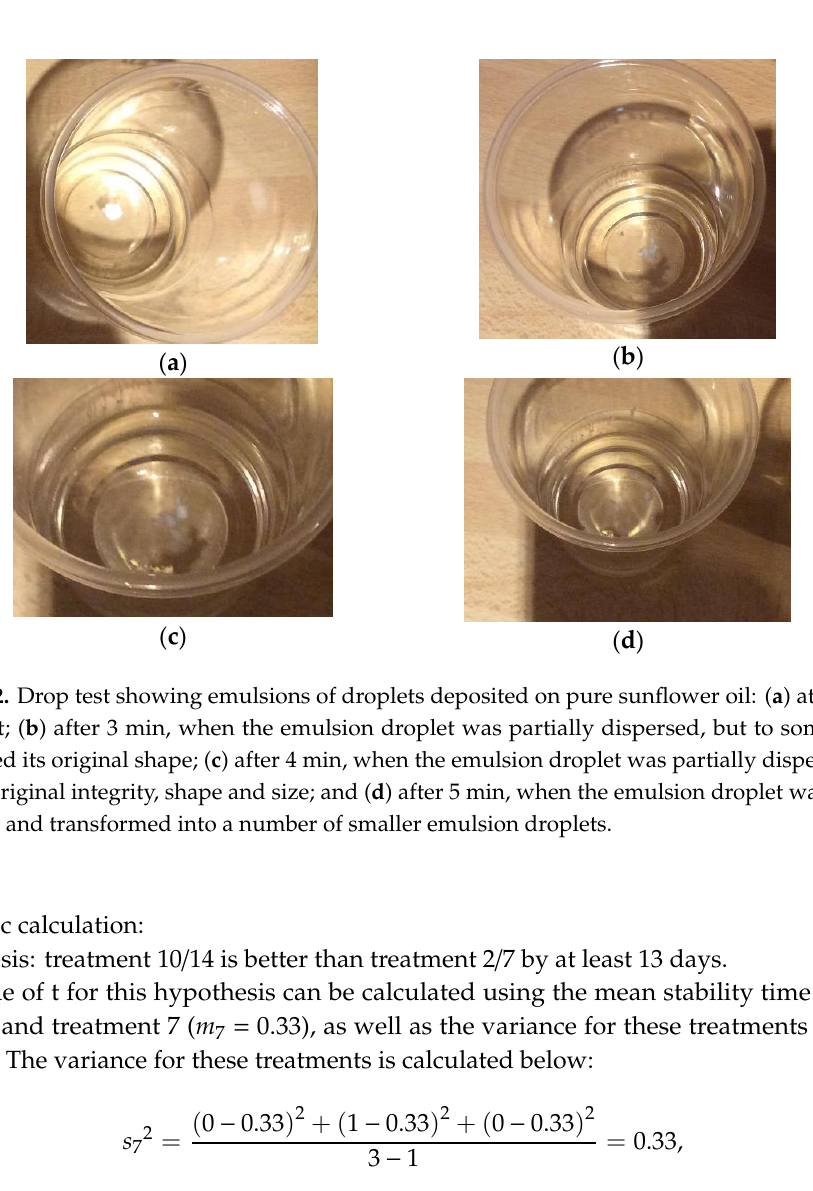
Figure A1. Drop test showing emulsions of droplets deposited on pure sunflower oil on the left and on water on the right: ( a ) at the start of the test; ( b ) after 8 min, when the emulsion droplet was completely dispersed while the one in water did not disperse; ( c ) after 40 min, when the emulsion droplet was completely dispersed while the one in water did not disperse; and ( d ) after 1 h, when the emulsion droplet was completely dispersed while the one in water did not disperse.